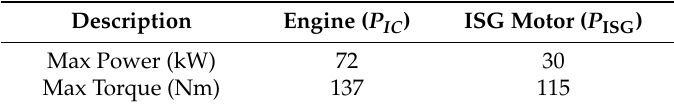
Table 4. Six types of typical driving cycles. Table 5. Power source parameters of the HEV.